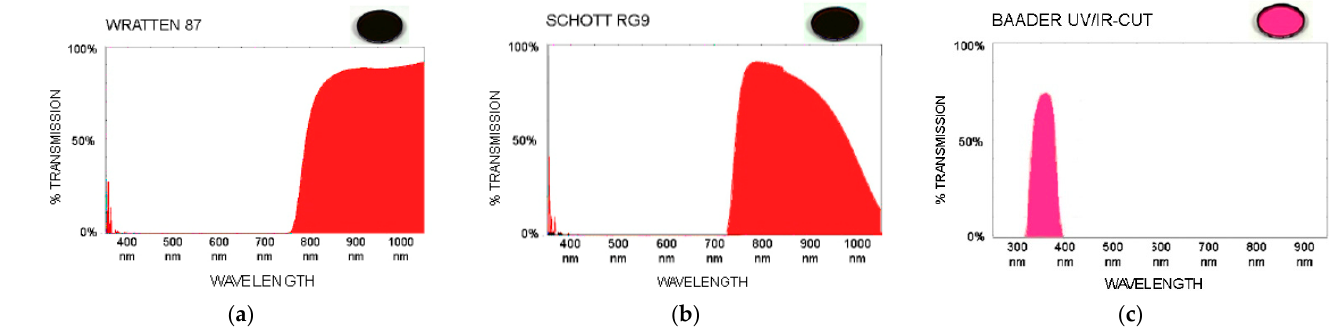
Figure 3. ( a ) IR Longpass filter Wratten 87; ( b ) IR Longpass filter Schott RG 9; ( c ) UV Shortpass filter Baader UV/IR-cut .